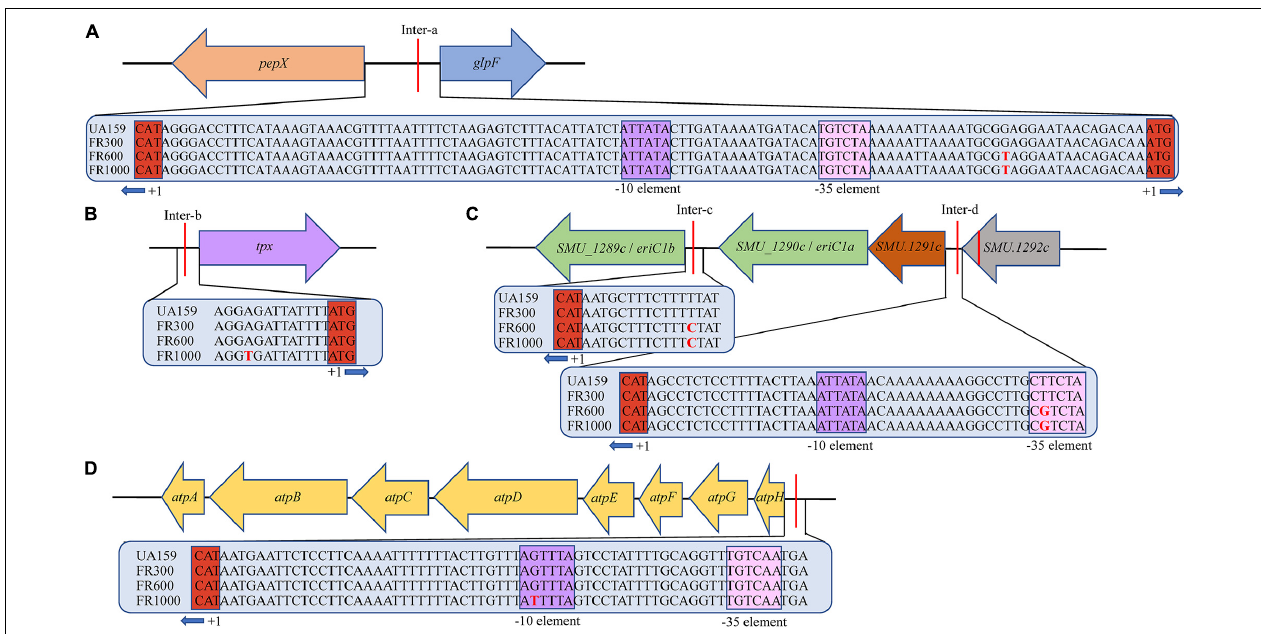
FIGURE 1 | Organization of gene clusters of S. mutans and their relation to intergenic SNPs. (A) Intergenic SNP upstream of pepX and glpF gene in FR600/FR1000. (B) Intergenic SNP upstream of tpx gene in FR1000. The -10A → T promoter mutation occurred in FR1000. (C) Intergenic SNP eriC1a ( SMU_1290c ) and eriC1b ( SMU_1289c ) in FR600 and FR1000. The -13T → C promoter mutation occurred in FR600 and FR1000. Intergenic SNPs of SMU_1292c and SMU_1291c in FR600 and FR1000. The -44T → G promoter mutation occurred in FR600 and FR1000. (D) Intergenic SNPs upstream of atpHGFEDCBA in FR1000. The -36G → T promoter mutation occurred in FR600 and FR1000. Sequences of intergenic regions were given in the blue bar. Red letter indicates SNPs; Purple box indicates putative -10 element (Pribnow box, share conserved sequences TATAAT/ATTATA); Pink box indicates putative -35 element (share conserved sequences TTGACA/TGTCAA); Red box indicates translation start site (ATG/CAT) of the